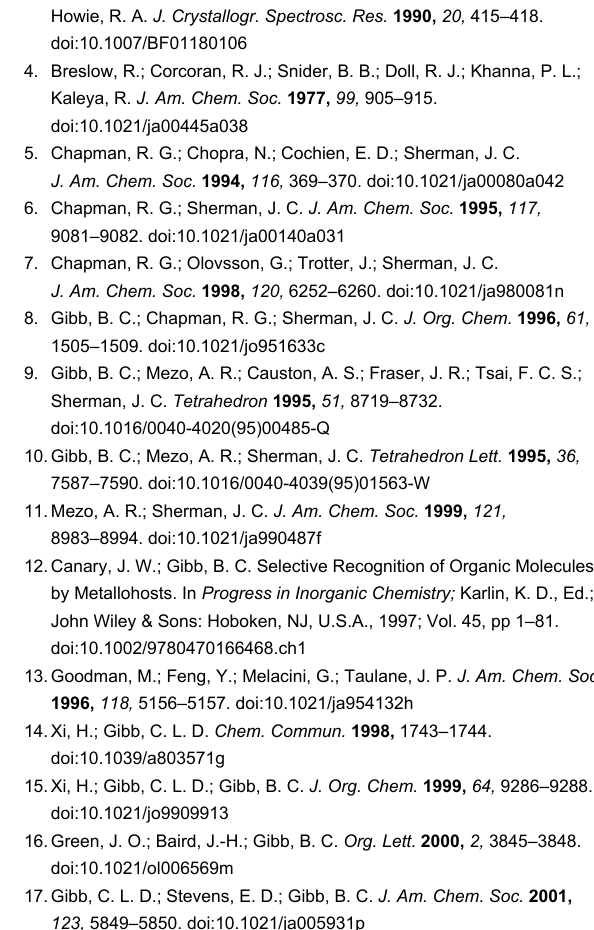
commented on in supramolecular chemistry how difficult